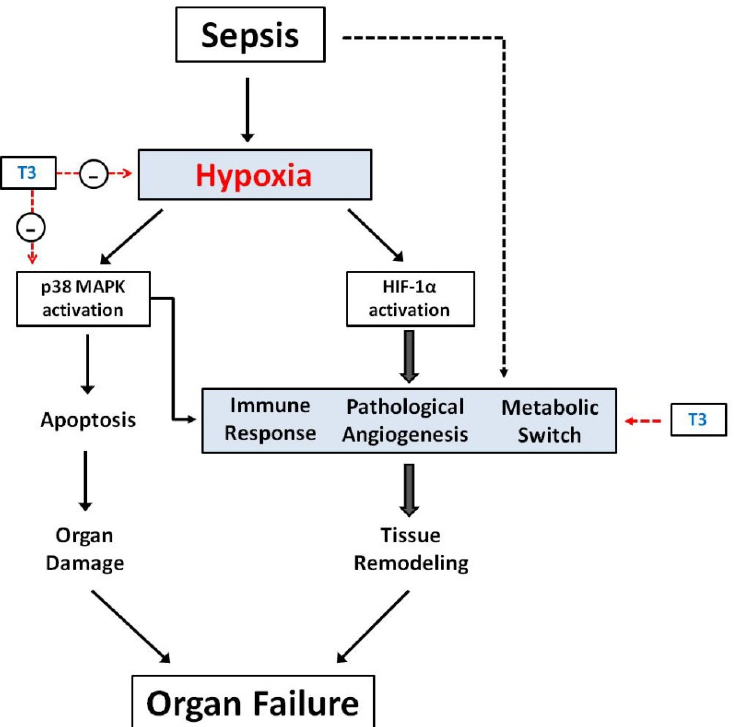
Figure 1. Tissue hypoxia has a critical role in the main mechanisms that results in organ failure due to sepsis (the dotted black line represents the hypoxia-independent complex pathophysiological mechanisms, resulting in sepsis immune response, pathological angiogenesis, and metabolic switch; these are not reviewed here). Here, we depict possible sites of TH action (red dotted lines): (1) triiodothyronine (T3) improves tissue hypoxia and inhibits pro-apoptotic kinase signaling activation and (2) affects the other septic mechanisms in a complex way. Eventually, T3 may prevent organ failure.